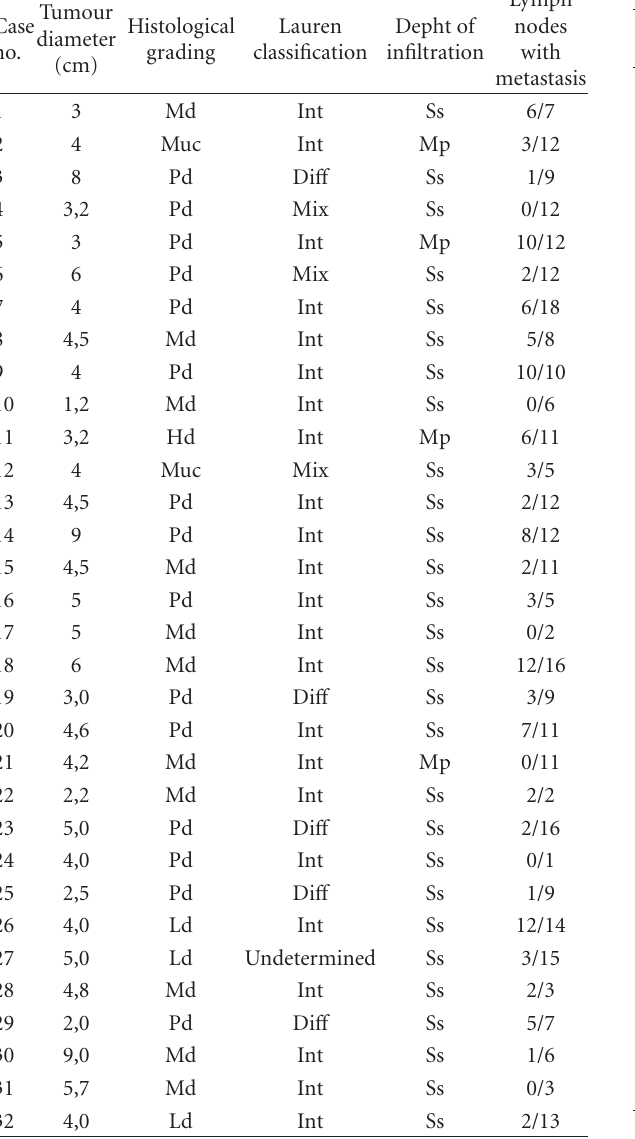
Table 1: Characteristics of gastric cardiac carcinomas. Table 2: Neuroendocrine di ff erentiation in gastric carcinomas localized to the cardia and long-term use of proton pump